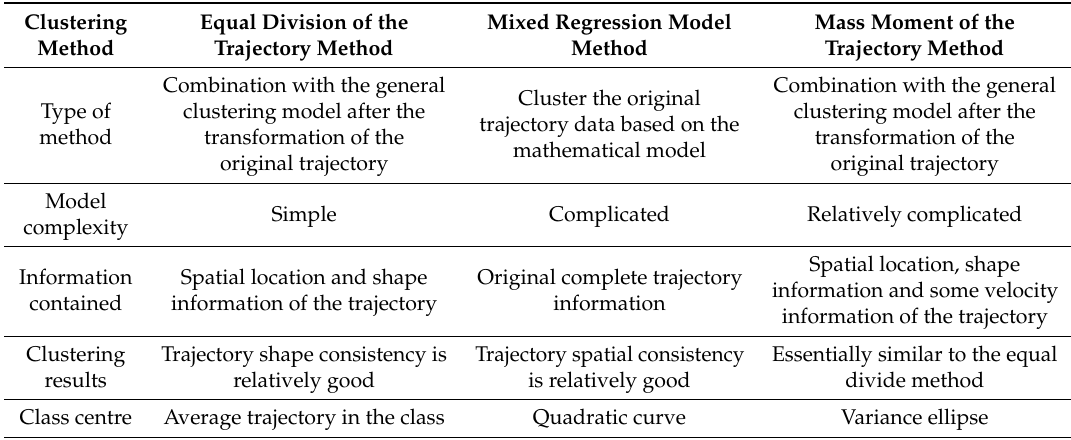
Table 4. Comparison of three clustering methods for the trajectory.